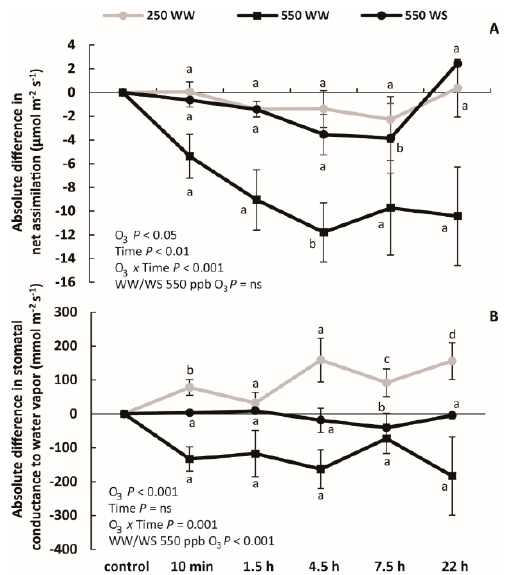
Figure 3. Absolute O 3 -dependent differences (mean ± SE) in net assimilation rate ( A ) and stomatal conductance to water vapor ( B ) in O 3 -treated well-watered and water-stressed B. nigra plants. The differences are given as the average values of A and g s in control plants minus the average values at different time-points during recovery. The values between control and different time-points were compared by paired sample t -tests and significant differences ( p < 0.05) are indicated by